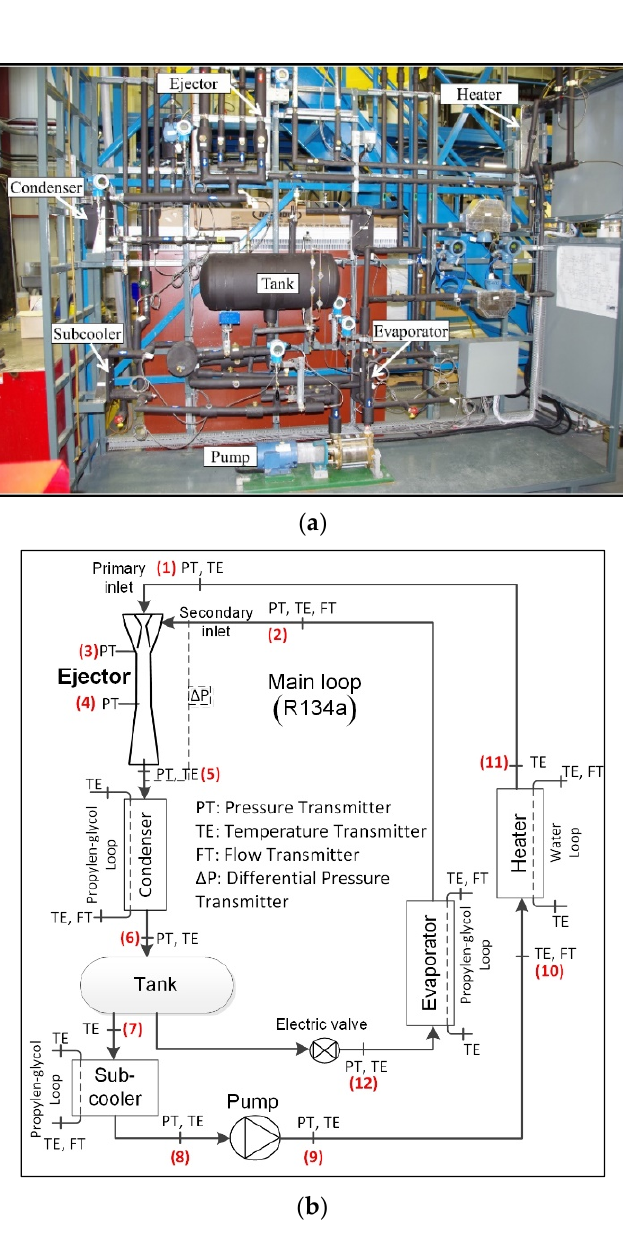
Figure 2. Test bench of the two-phase ejector: ( a ) Experimental setup at CanmetENERGY-Varennes; ( b ) Simplified diagram.